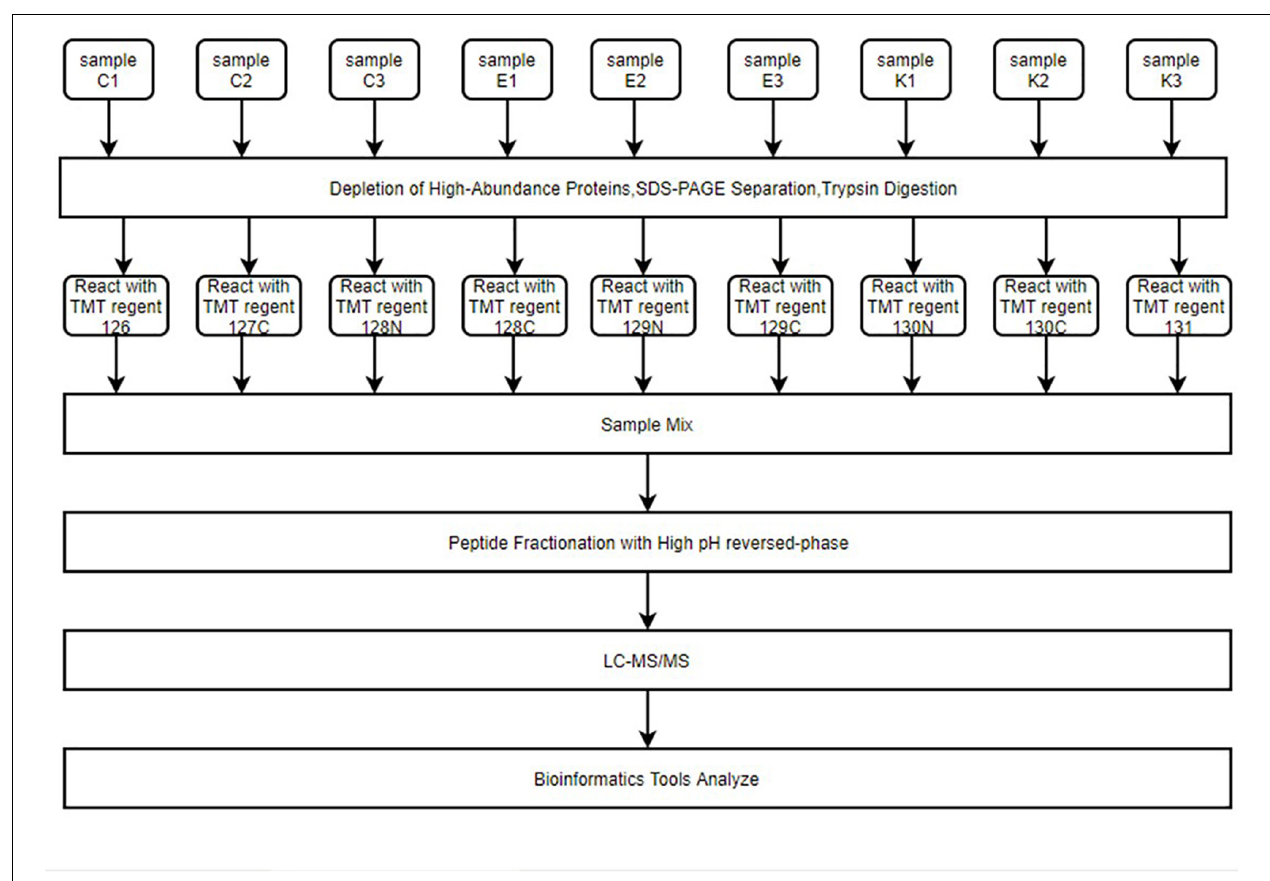
FIGURE 2 | The entire proteomics experimental process. Hippocampus samples were reacted with different isotope-labeling TMT regents after immunoaffinity depletion of high-abundance plasma proteins, SDS-PAGE separation, and FASP digestion. Samples were mixed and peptides fractured by high pH reverse-phase chromatography. Finally, LC–MS/MS was used for high-throughput screening of samples. Peptides were then analyzed for function using multiple bioinformatics tools. TABLE 2 | Quantitative analysis of target peptide abundance. Peptide Protein accession